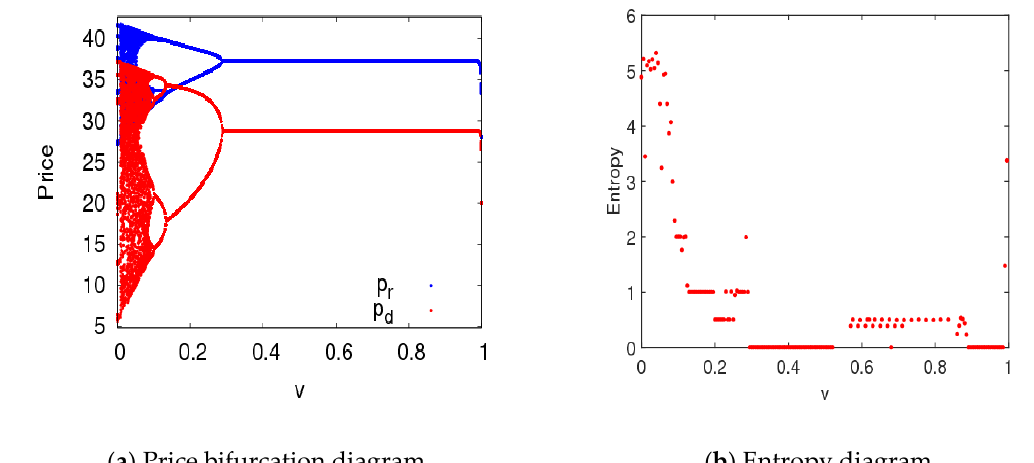
Figure 21. Evolution process and entropy of control System (11) with 𝑣 ∈ (0,1) when 𝛼 1 = 0.0156 and 𝛼 2 = 0.008.